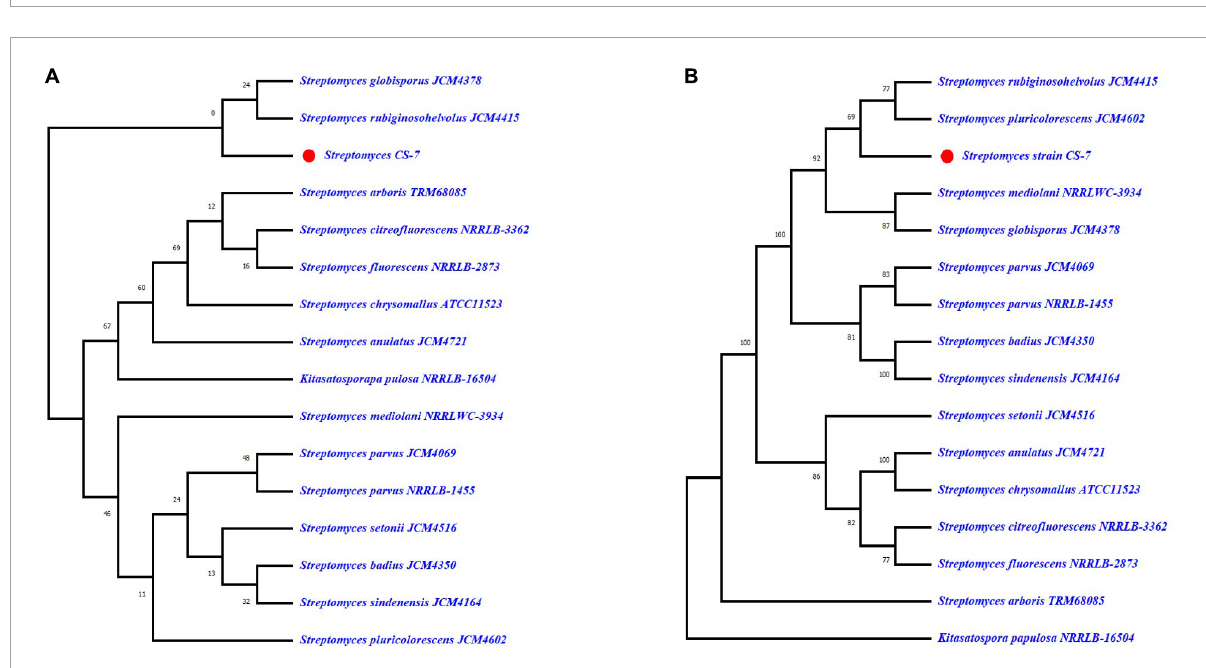
FIGURE5 Genome BLAST Distance Phylogeny (GBDP) computed taxonomy for Streptomyces CS-7. GBDP intergenomic distances were derived from complete proteomes, and the trees were inferred using FastME. (A) Phylogenetic constructed from 16S rRNA and (B) phylogenetic tree constructed from whole genome